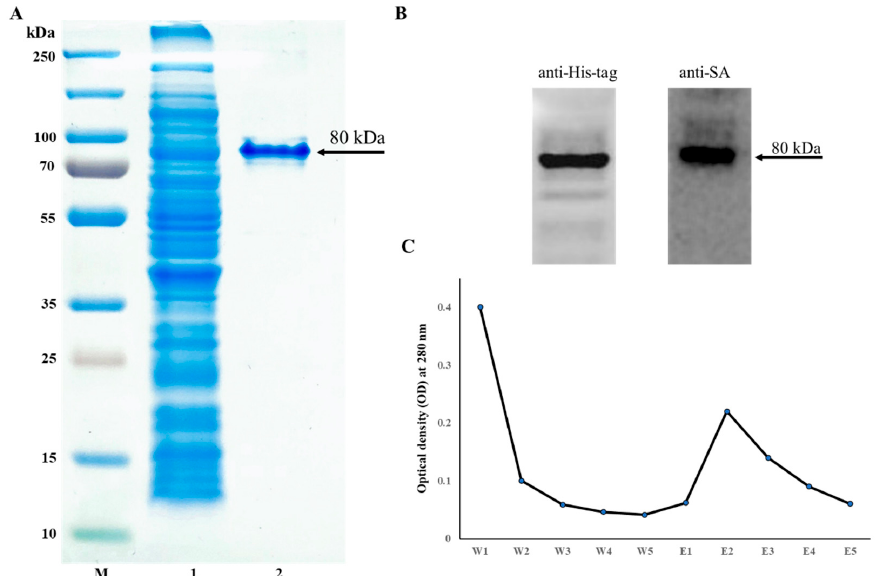
Figure 3. ( A ) SDS-PAGE imaged as (M) protein ladder, (1) crude bacterial lysate, (2) purified MYR- coreSA fusion protein; ( B ) Western blot of purified MYR-coreSA fusion protein against anti-His-tag and anti-SA; ( C ) elution profile of MYR-coreSA fusion protein using five washes and five elutions.